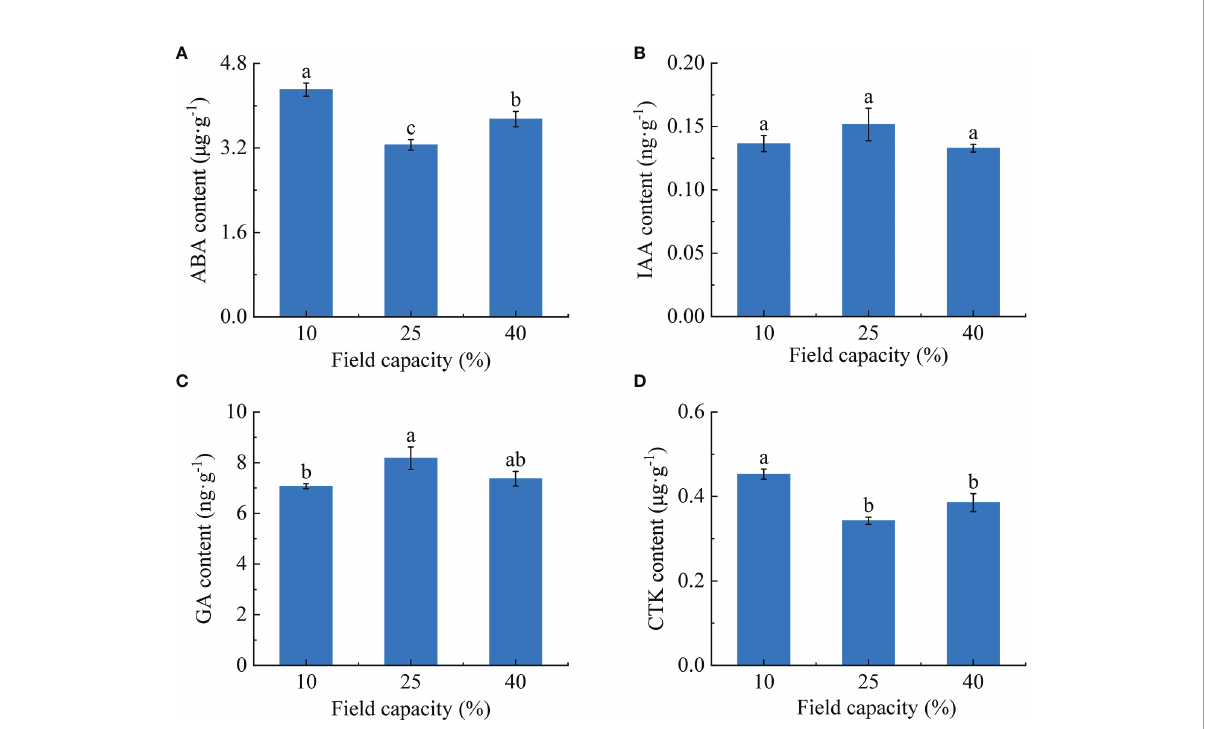
FIGURE 6 Effects of different soil moisture on abscisic acid (ABA) (A) , indole-3-acetic acid (IAA) (B) , gibberellin (GA) (C) and cytokinin (CTK) (D) contents of K hirsuta. Results were analyzed by one-way ANOVA and tested for signi fi cance of difference by Duncan multiple-range method. Each value represents the mean ± standard error. Each experiment was repeated four times. Different letters indicate that the differences between treatments were signi fi cant ( P < 0.05).